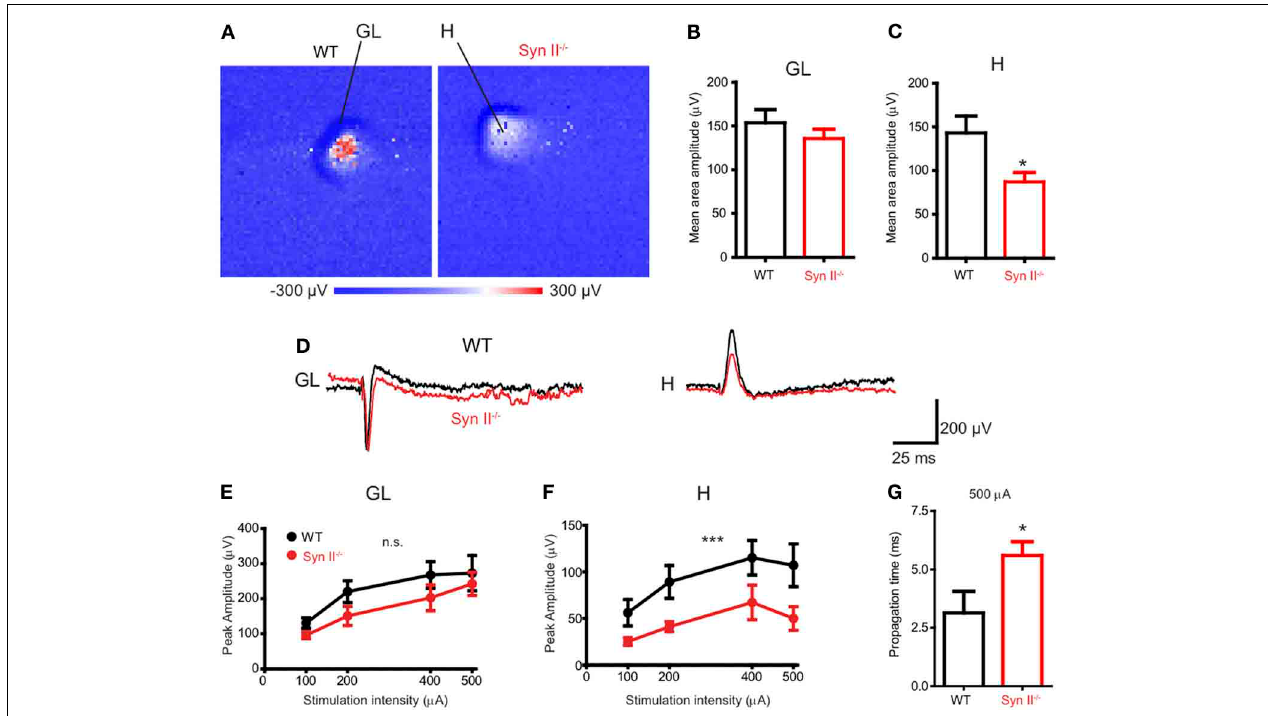
t -test. (D) Representative traces from one APS-MEA electrode from both genotypes located in the granule layer and hilus, respectively. (E,F) Stimulation-response curves representing the mean ( ± s.e.m.) peak amplitudes of three randomly selected electrodes from the granule layer (E) or hilus (F) at increasing stimulation intensities; ∗∗∗ p < 0 . 001, Two-Way ANOVA. (G) Mean ( ± s.e.m.) stimulus propagation time from GL to H at a stimulation intensity of 500 μ A; ∗ p < 0 . 05, two-tailed unpaired Student’s t-